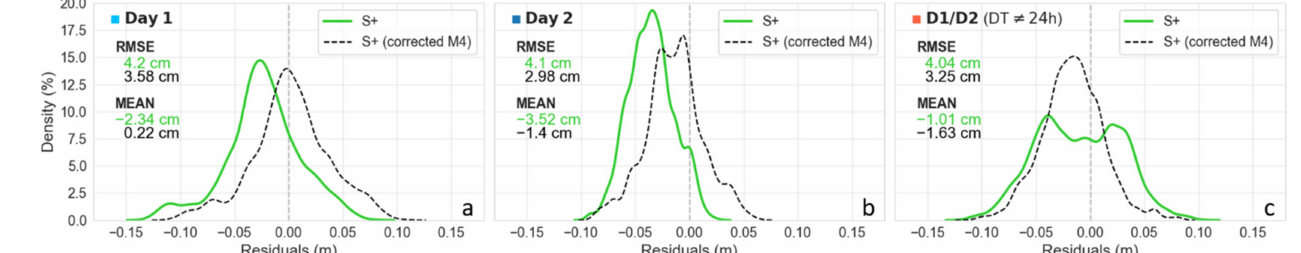
Figure 14. Crossover residuals density distributions for S+ (green) and S+ empirically corrected from M4 amplitude error (dashed black line). The root-mean-square errors (RMSE) and the mean are represented for each configuration, in the corresponding colour. Only distributions associated to intra-day (( a ) day 1, ( b ) day 2) and inter-day with time interval different from 24 h ( c ) are shown.